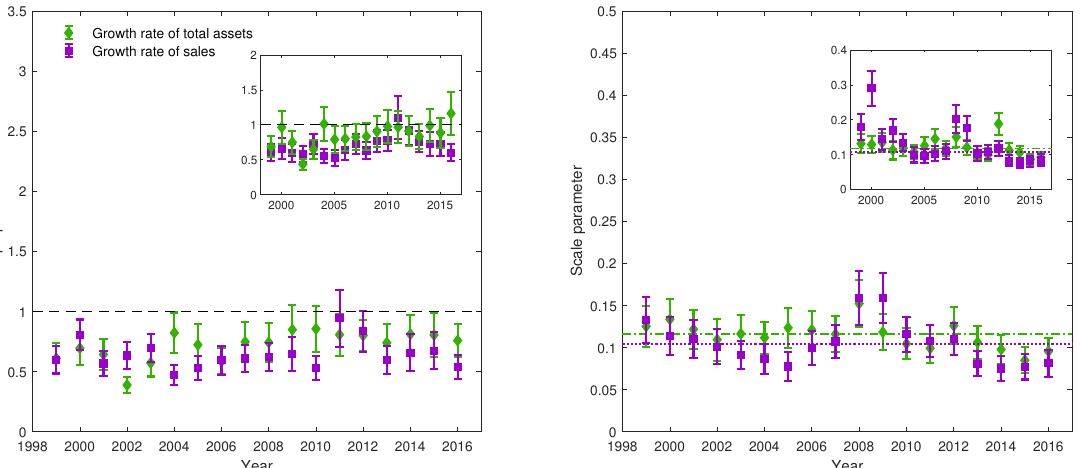
Figure 4. Estimates of the shape and scale parameter of the Subbotin distribution for growth rates of total assets and sales. Error bars show two standard errors. The results refer to the 200 largest long-lived firms according to their sales in 2016. The dotted line (sales) and dashed line with dots (total assets) in the scale parameter figure represent the median of the